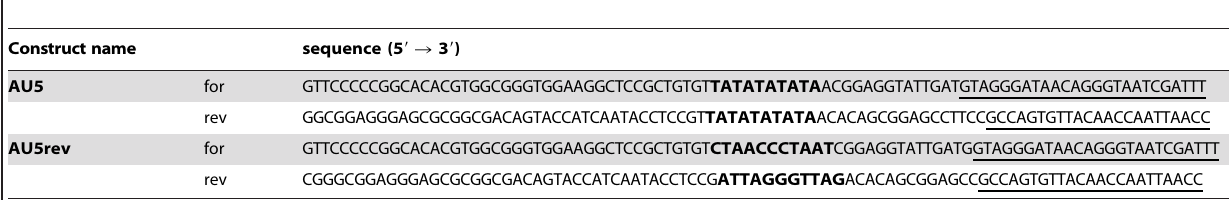
Table 1. Primers used for cloning and generation of mutant and revertant AU5